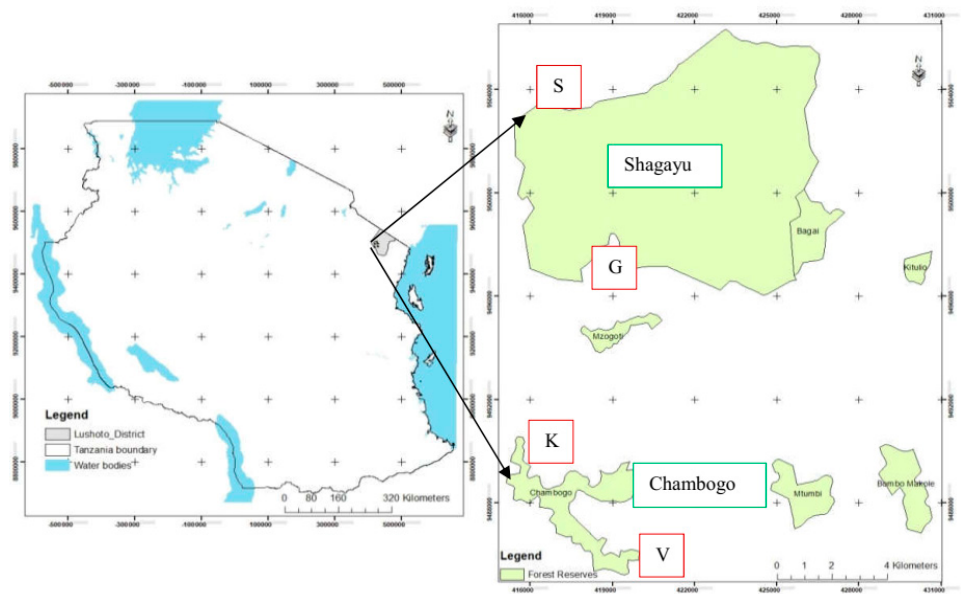
Figure 1. Map covering the four study villages around the Shagayu (Sunga and Goka) and Chambogo (Kibaoni and Viti) forests. Adopted from [28].